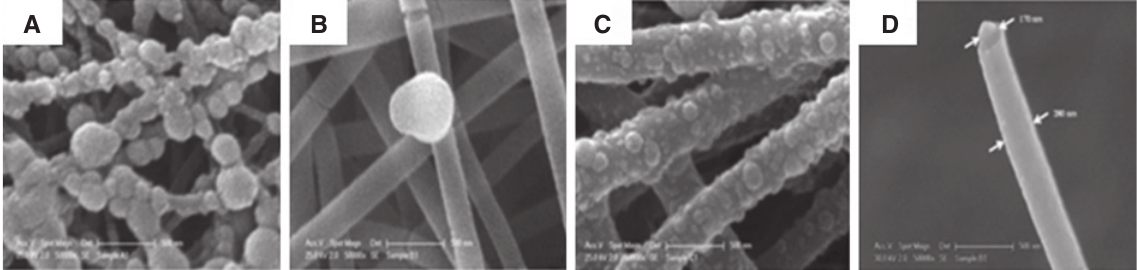
Figure 7: SEM observations of the prepared nanofibers: PA6 (A), PS (B), and PUR (C). A detailed view of one polystyrene fiber coated with anatase is presented in (D). For details, see Ref. [41]; reprinted with permission from Elsevier.